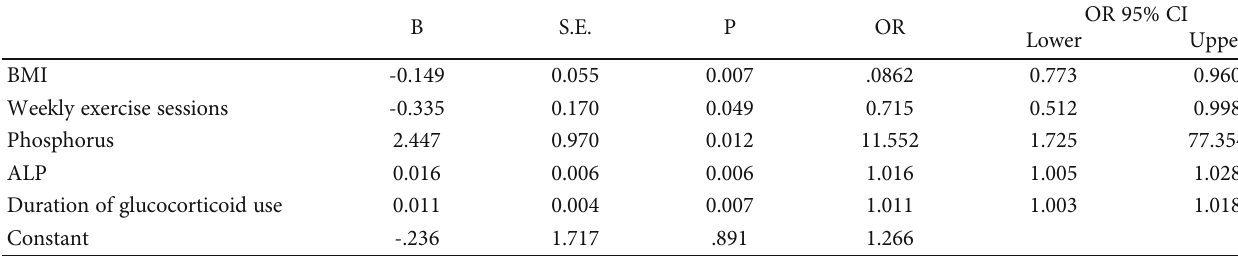
Table 4: Binary logistic regression analysis of bone mineral